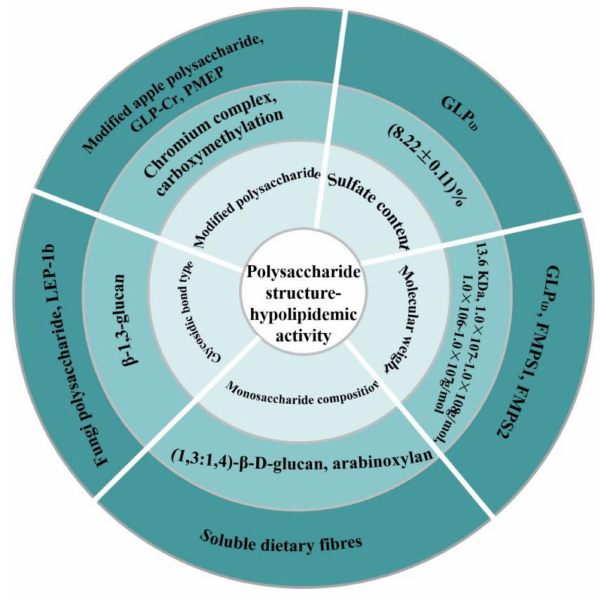
Figure 3. Polysaccharide structure–antihyperlipidemic activity